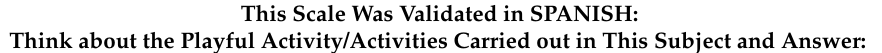
Table A2. Questionnaire on Motivation for Cooperative Playful Learning Strategies (CMELAC) in